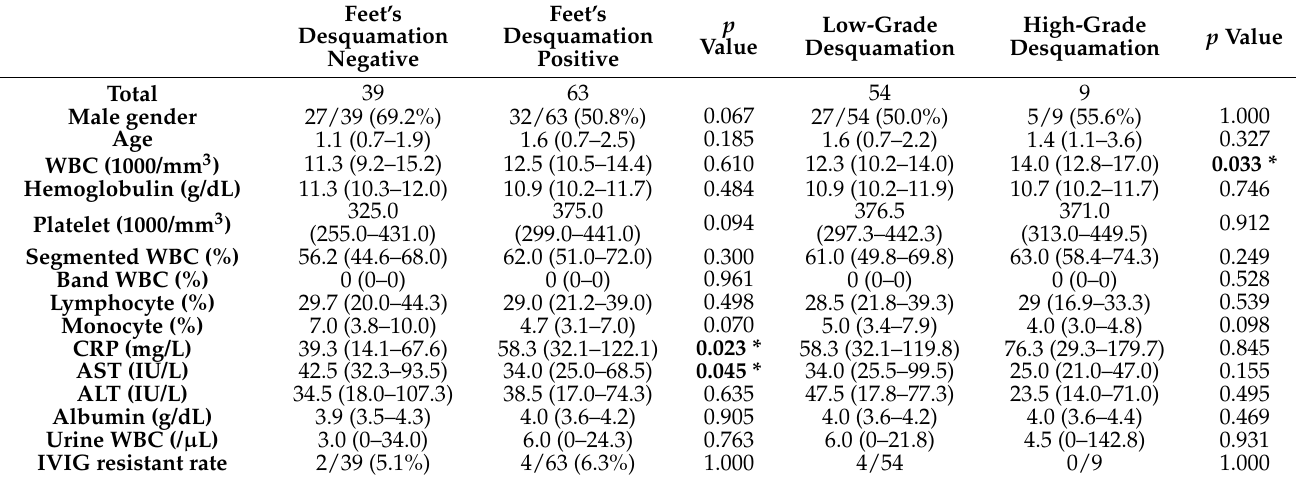
Table 3. Patients’ laboratory data of Kawasaki disease before IVIG (with feet’s desquamation positive or not).